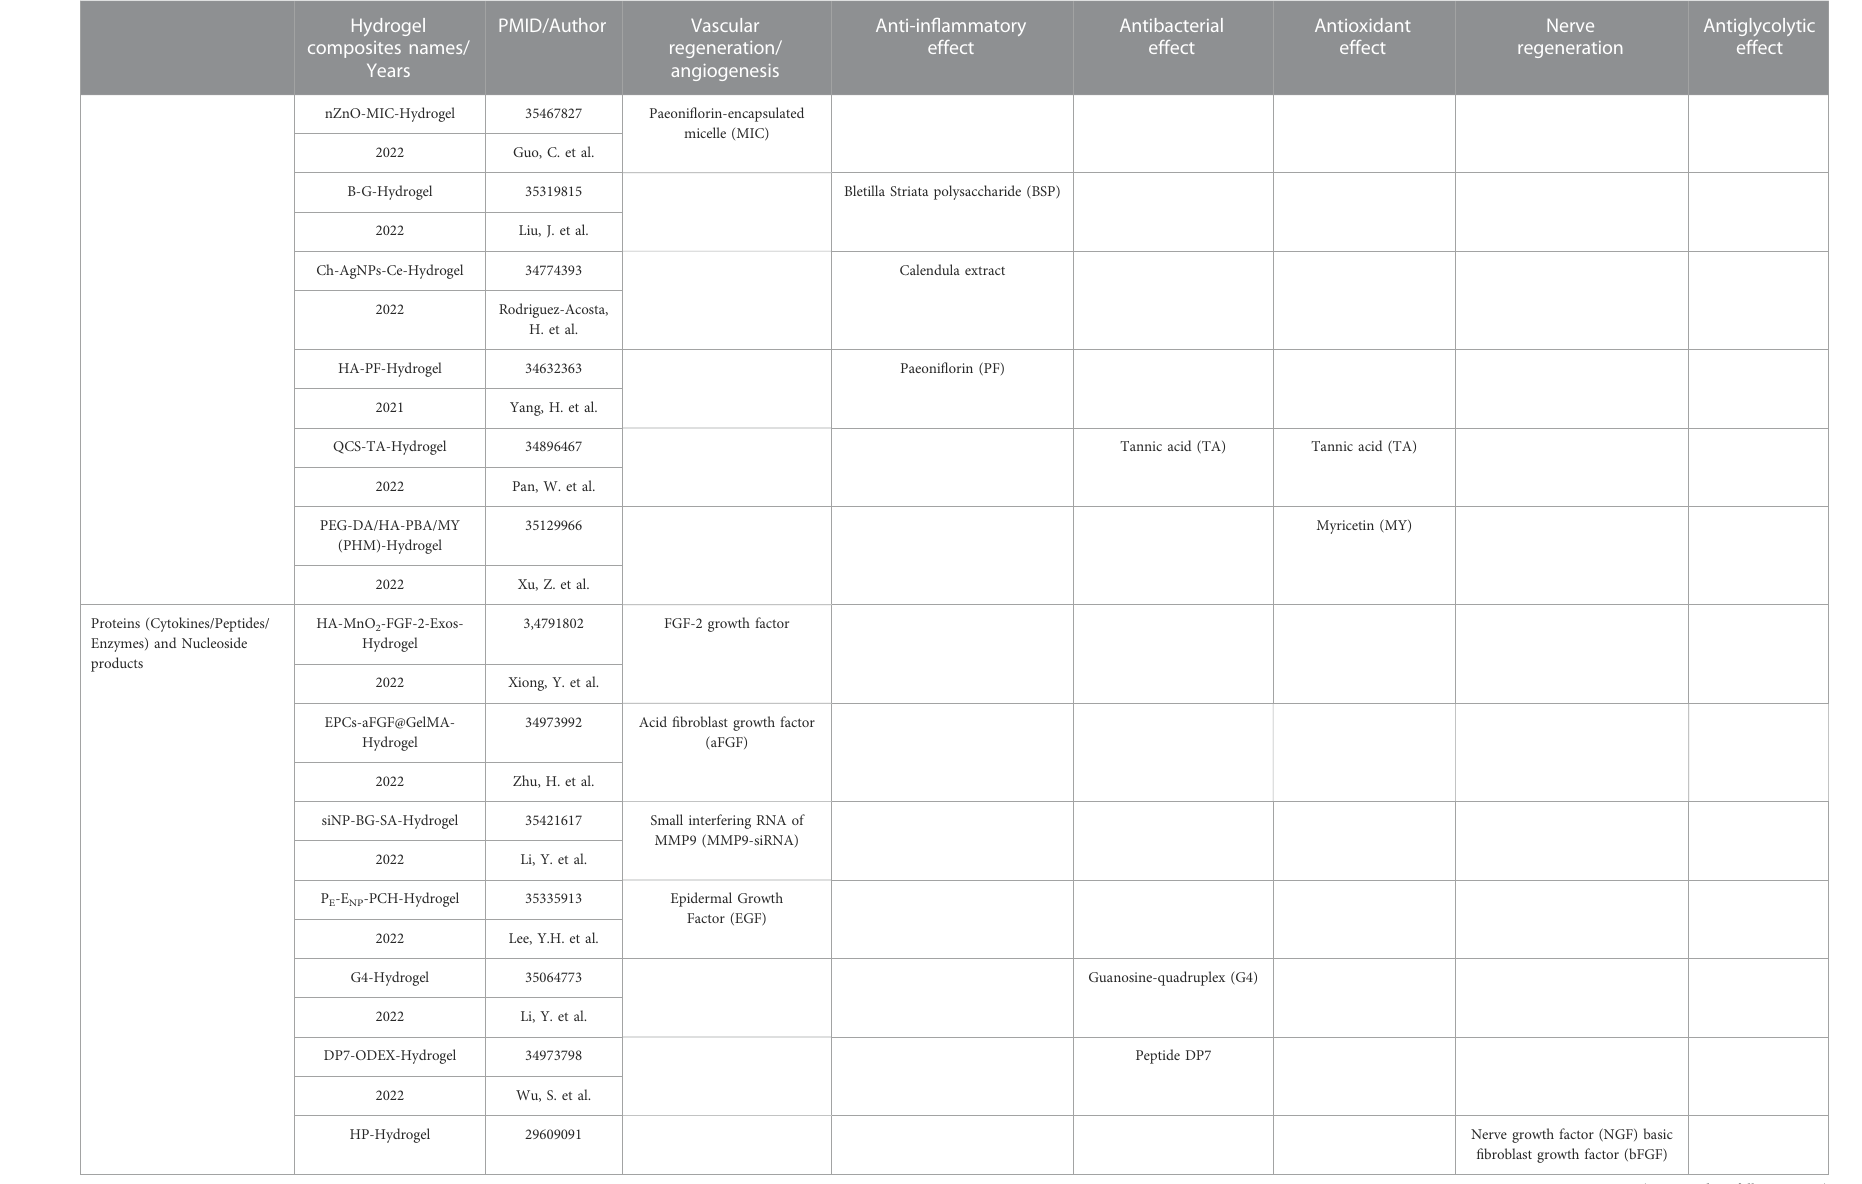
Proteins (Cytokines/Peptides/ Enzymes) and Nucleoside